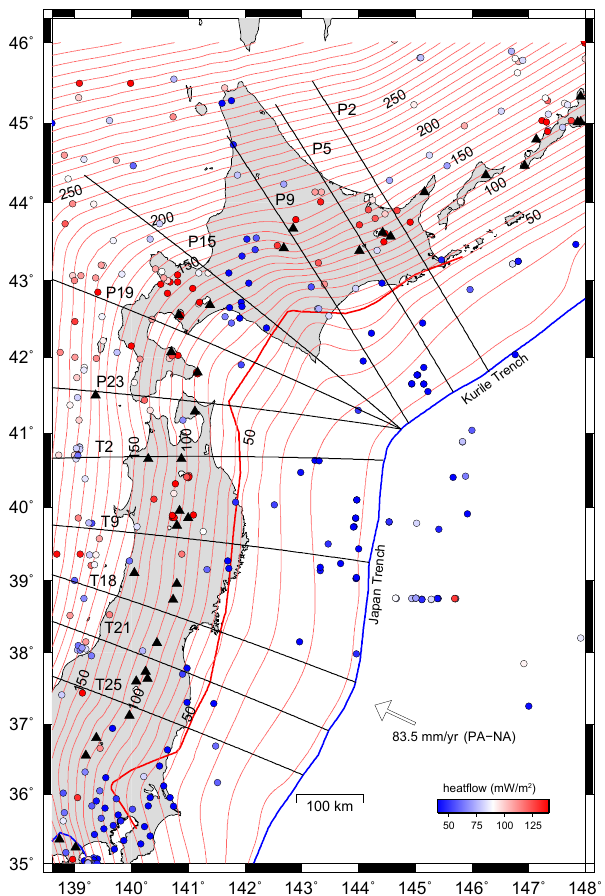
Fig. 1. Location of cross sections used in the thermal modeling of the Tohoku-Hokkaido subduction system. The thin red lines show the depth contours (in km) to the Pacific (PA) slab (from Zhao et al., 1997; Kita et al., 2010b). Heat flow (Tanaka et al., 2004) is shown with the colored circles. Volcanoes are shown in black triangles. The down-dip limit of low-angle thrust events from Kita et al. (2010a), which is taken to be the down-dip limit of the region of strong seis- mic coupling between upper and lower plate, is shown in the bold red line. Cross sections are labeled following Kita (2009) with P2– P23 over Hokkaido and T2–T25 over Tohoku. Arrow shows Pacific (PA) to North America (NA) convergence.